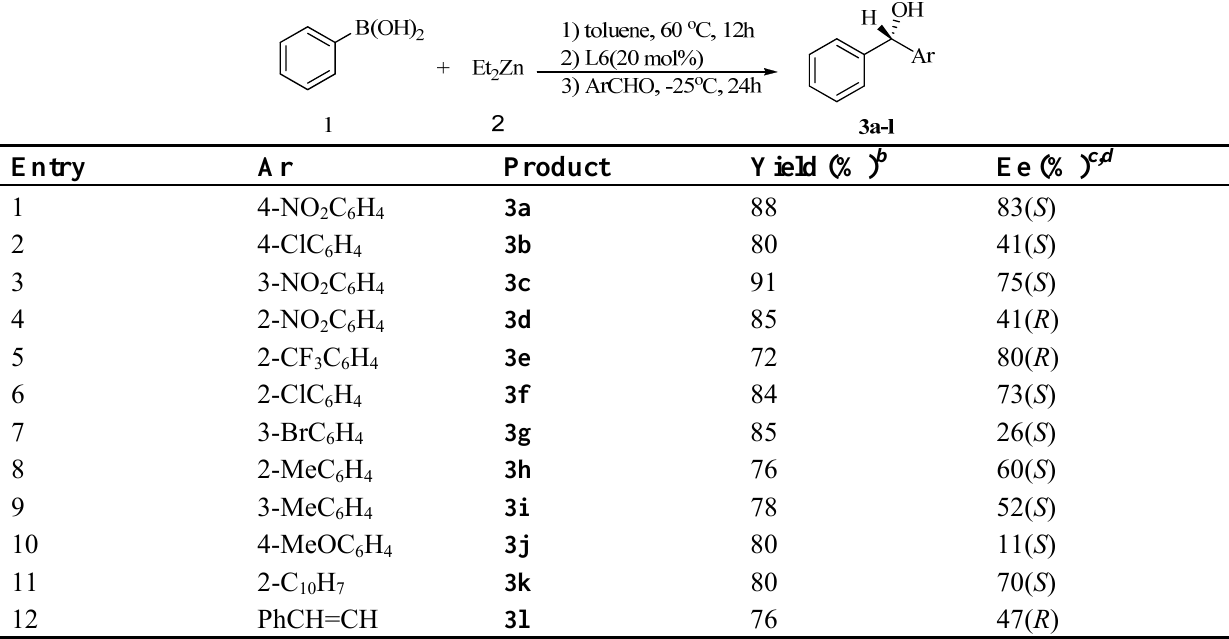
Table 2. Asymmetric Phenyl Transfer to Aromatic Aldehydes . a